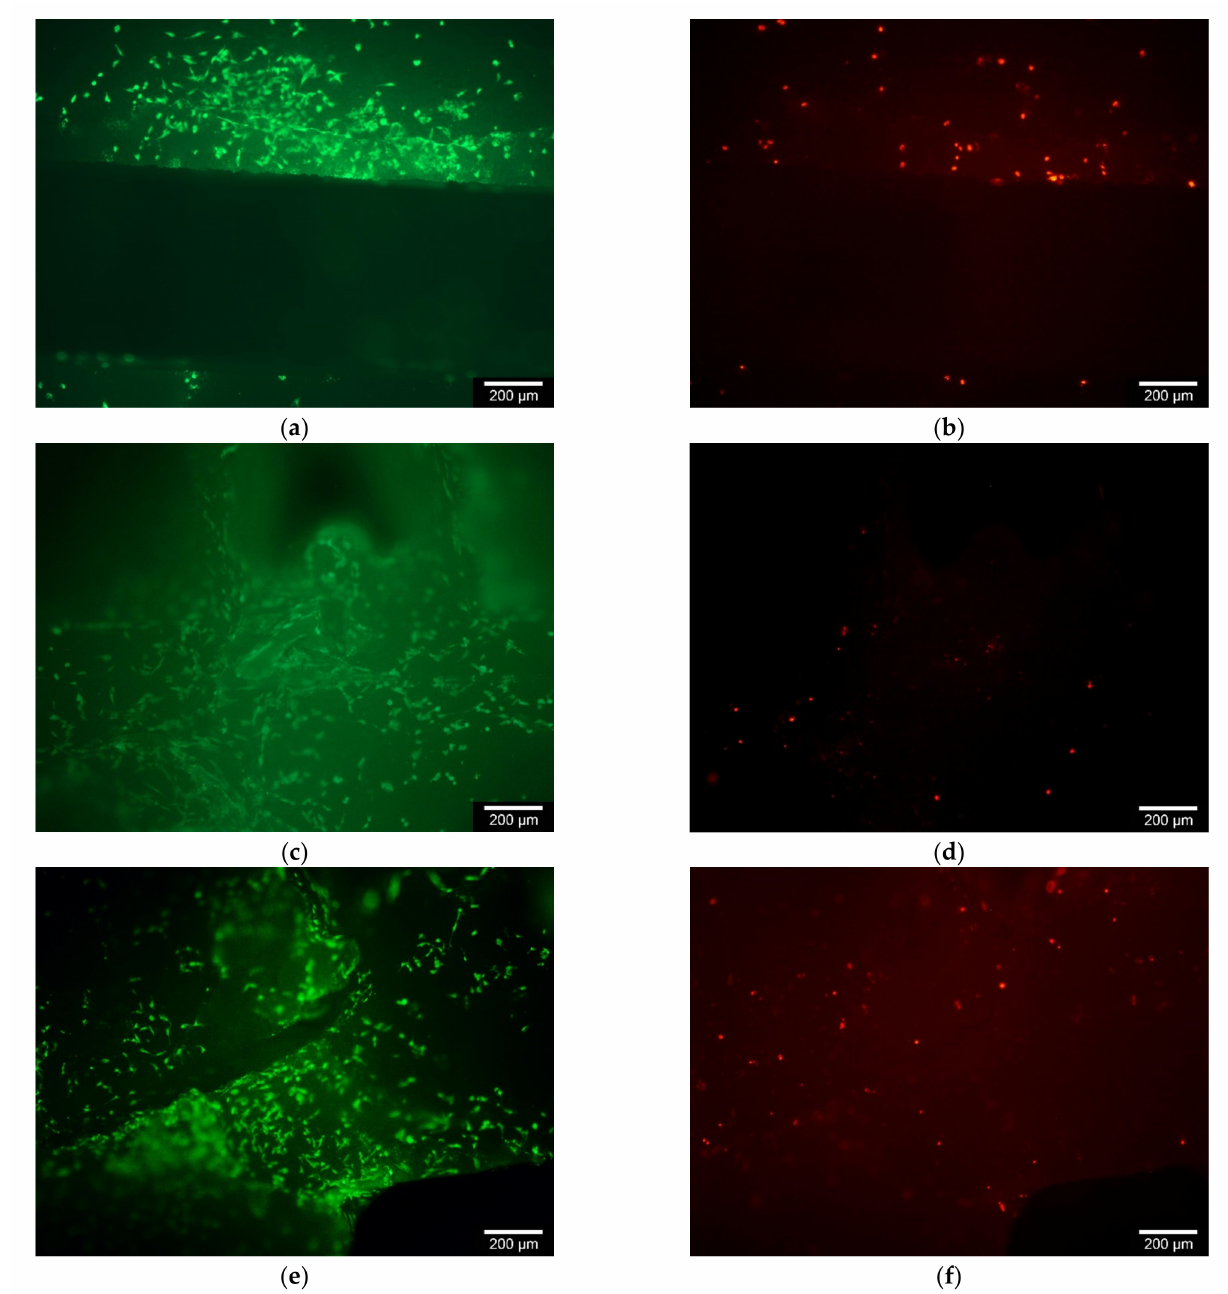
Figure A2. Exemplary Images of Live/Dead Staining 1000(2000) inner surface; ( a ) living cells after 3 days; ( b ) dead cells after 3 days; ( c ) living cells after 7 days; ( d ) dead cells after 7 days; ( e ) living cells after 10 days; ( f ) dead cells after 10